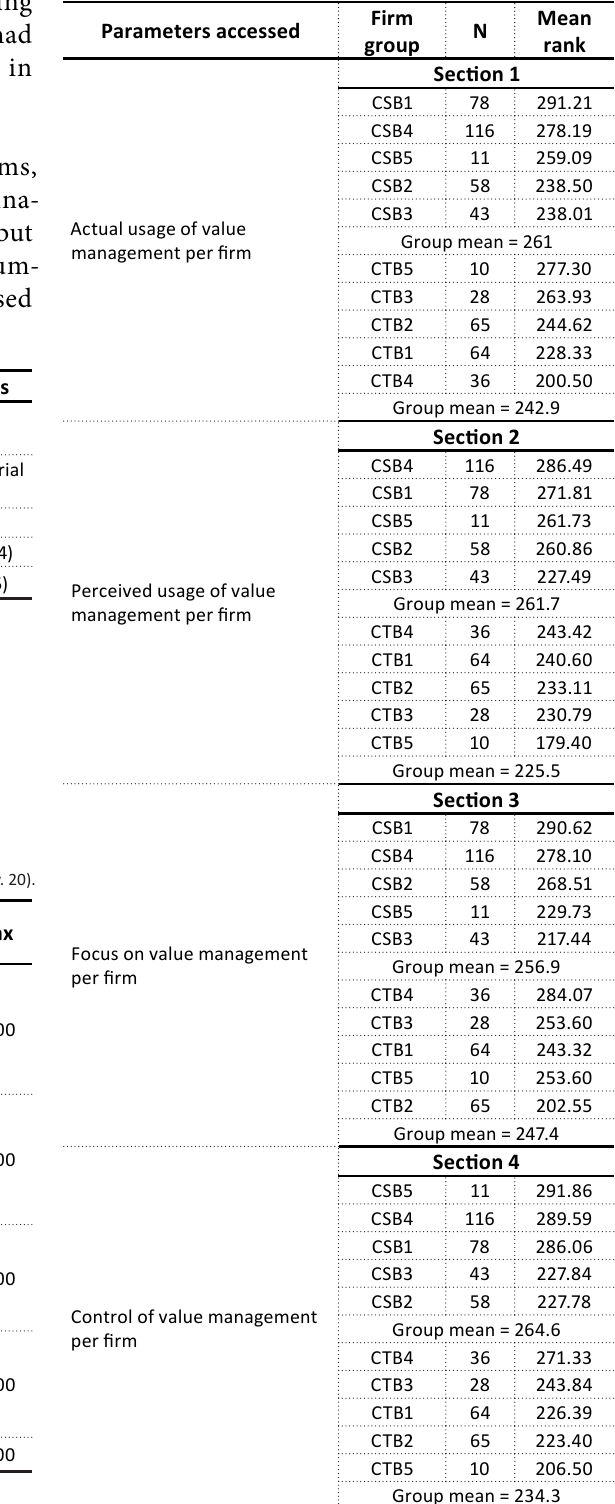
Table 2 describes the mean ranks as internally es- timated from the Kruskal-Wallis H